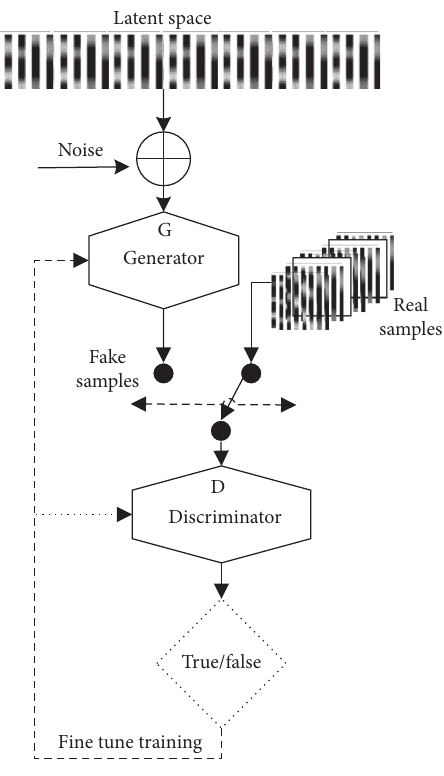
Figure 1: GAN training